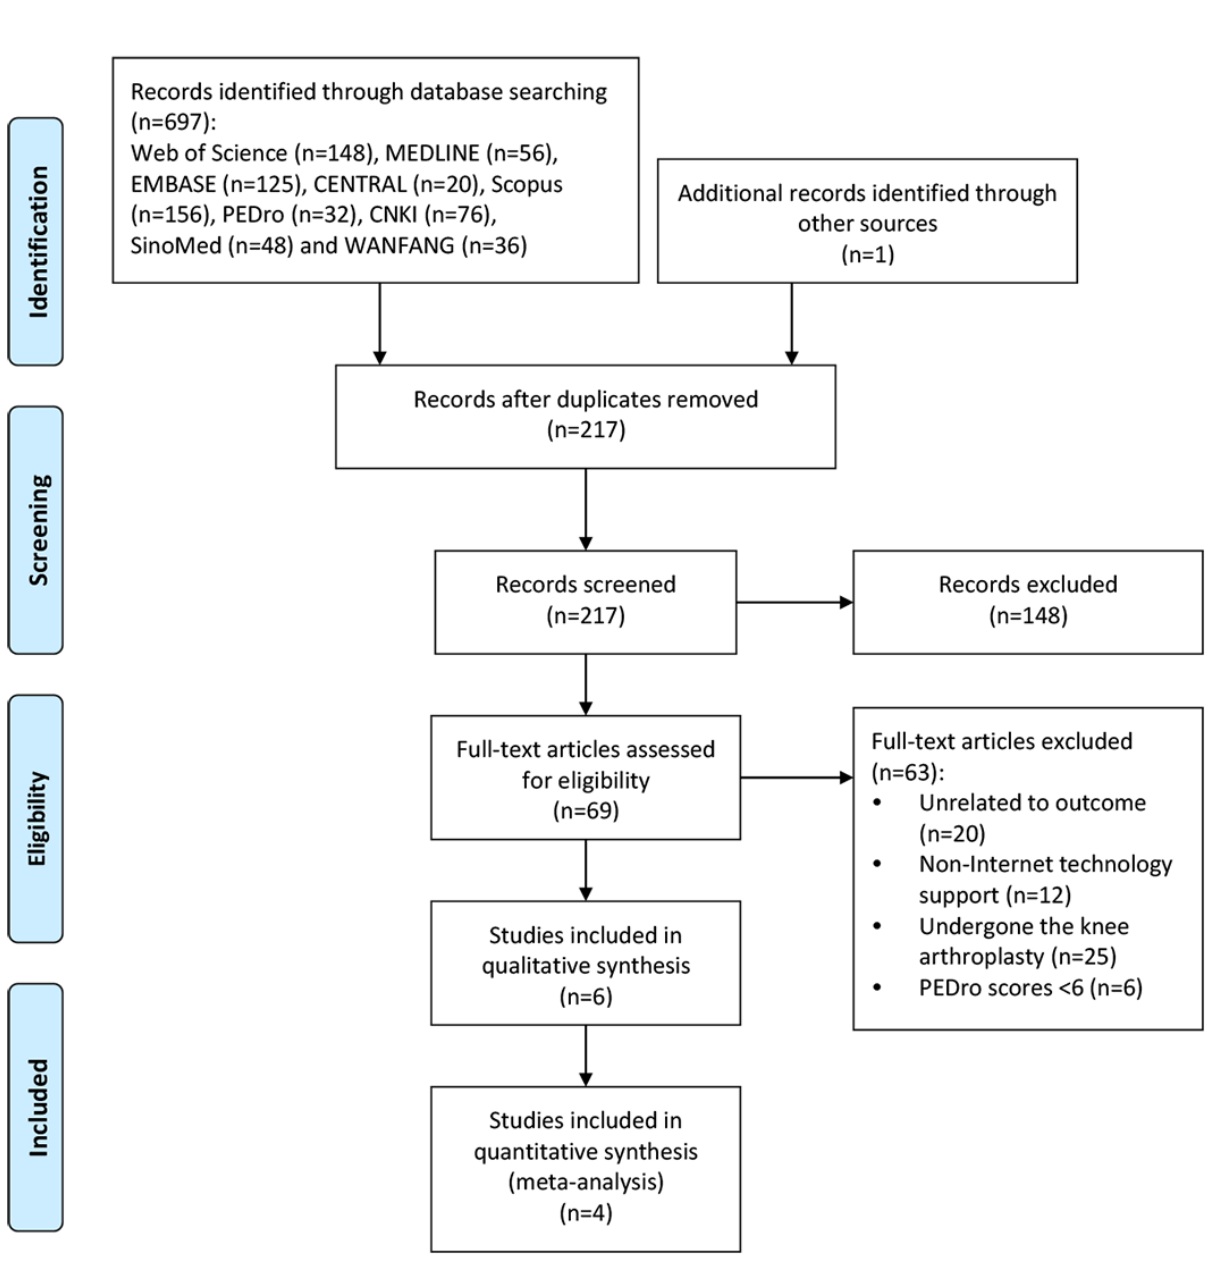
Figure 1. PRISMA (Preferred Reporting Items for Systematic reviews and Meta-Analyses) flow diagram. CENTRAL: Cochrane Central Register of Controlled Trials; EMBASE: Excerpta Medica Database; MEDLINE: Medical Literature Analysis and Retrieval System Online; PEDro: Physiotherapy Evidence Database; CNKI: China National Knowledge